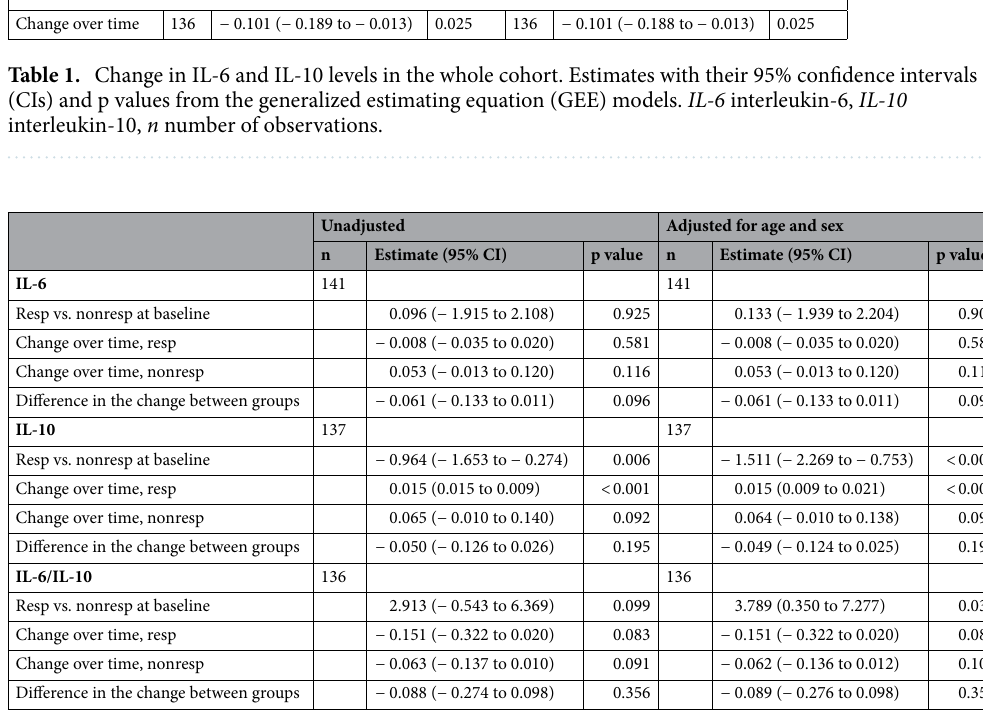
Table 2. Change in IL-6 and IL-10 levels among responders and nonresponders. Estimates with their 95% CIs and p-values from the GEE models. IL‑6 interleukin-6, IL‑10 interleukin-10, n number of observations.